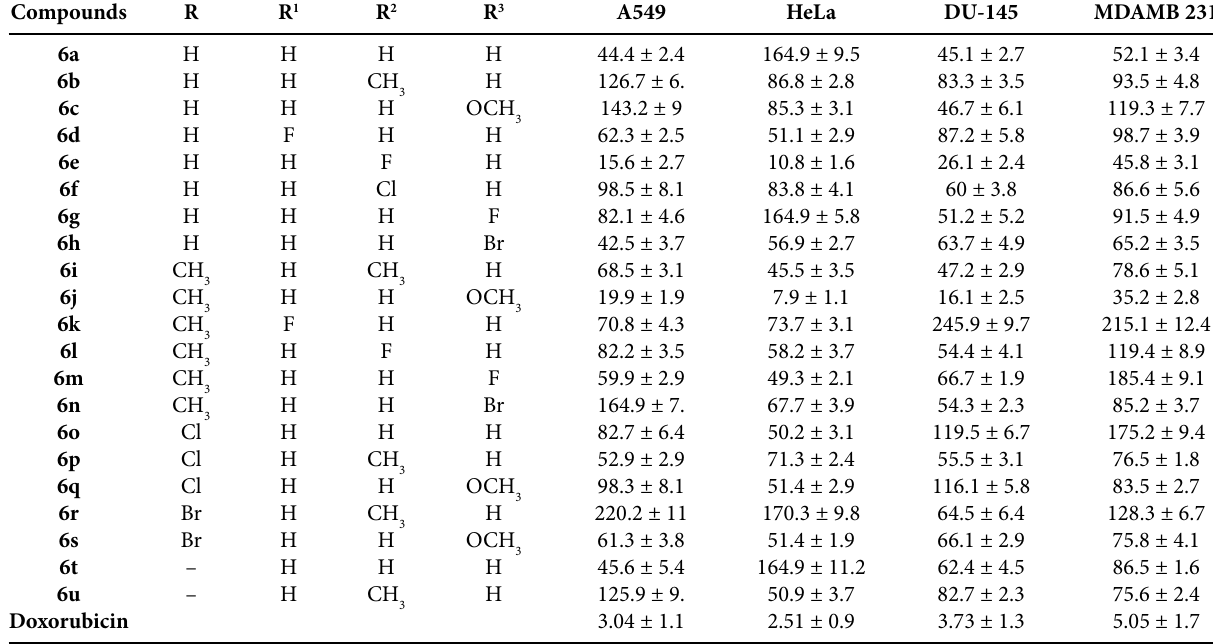
Table 3 . Anti-proliferative activity of pyrazolylmethanones